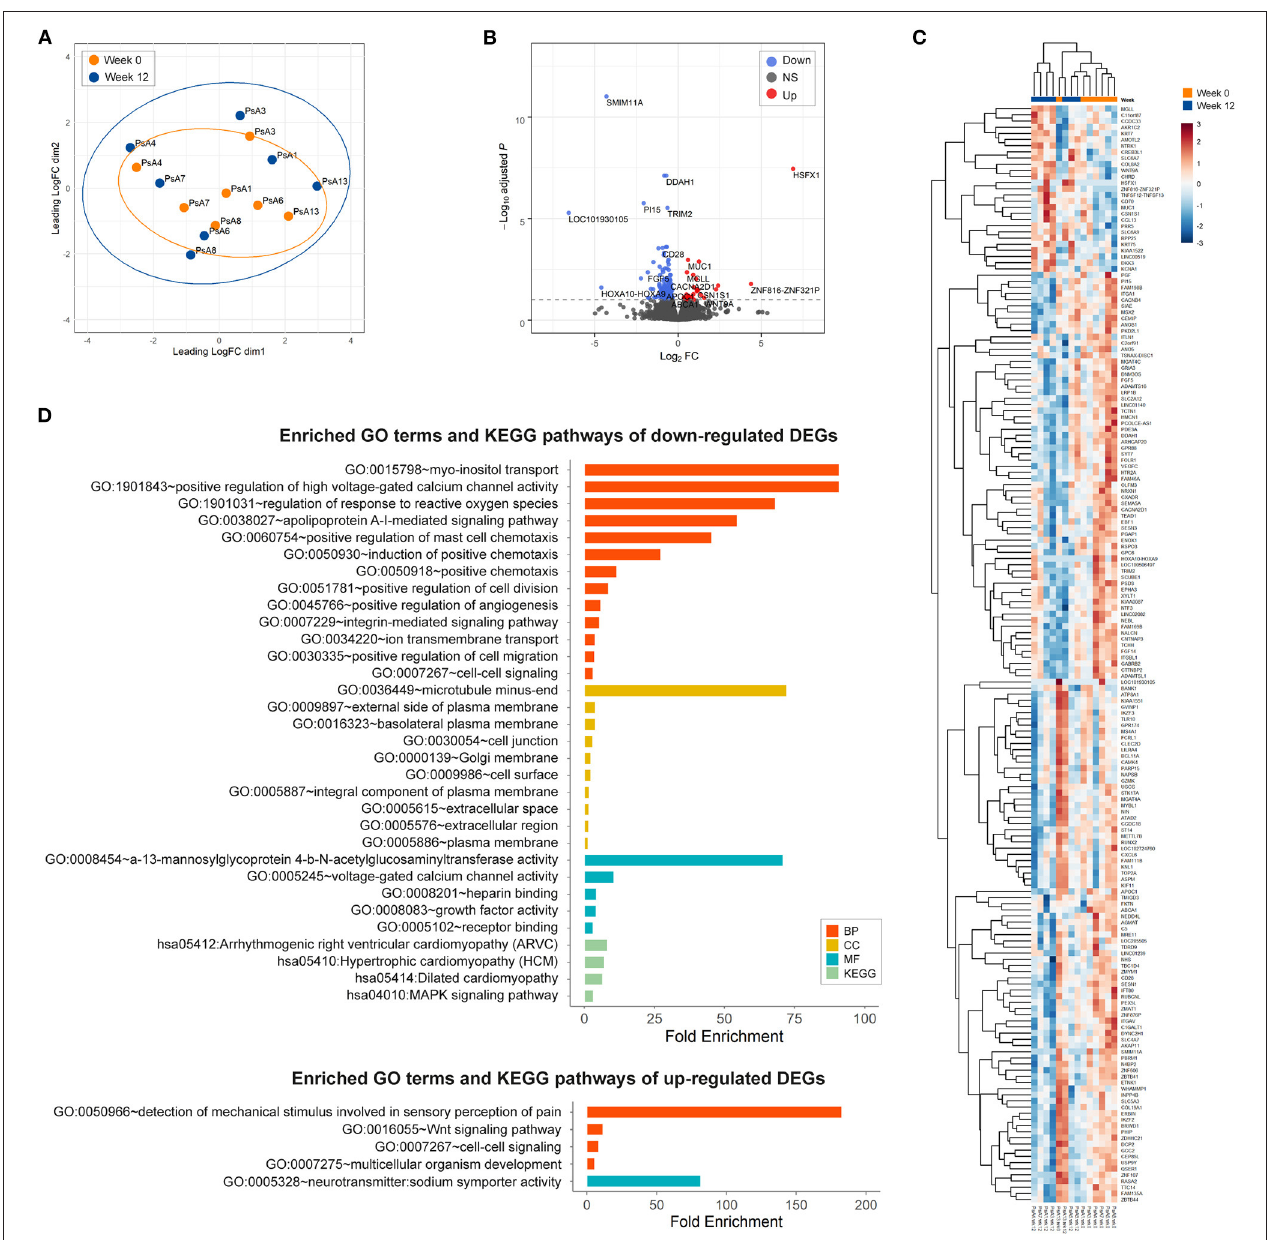
FIGURE 3 | Differential gene expression and pathway analysis of changes in psoriatic arthritis synovium 12 weeks after treatment with ustekinumab. (A) Multidimensional scaling (MDS) plot of gene expression (logCPM) in pre-treatment (red, week 0, n = 7) and post-treatment (blue, week 12, n = 7) synovium reveals no distinct separation by the treatment effect. (B) A volcano plot identifying significantly differentially expressed genes (DEGs) in response to IL-23p40/IL-12p40 blockade with ustekinumab (FDR < 0.1, dashed line): red, upregulated genes; blue, downregulated genes; black, non-differentially expressed genes. (C) Hierarchical cluster analysis of all significant genes modulated by the treatment separates pre- and post-treated groups. Normalized scaled log2 gene expression levels are shown. (D) The enriched ( p < 0.05) gene ontology (GO) terms and KEGG pathways of upregulated and downregulated DEGs in psoriatic arthritis synovium in response to the treatment with ustekinumab identified by DAVID. DEGs between pre- and post-treated groups were categorized into the three main categories of gene ontology classification: BP, biological process; CC, cellular component; MF, molecular function KEGG Kyoto Encyclopedia of Genes and